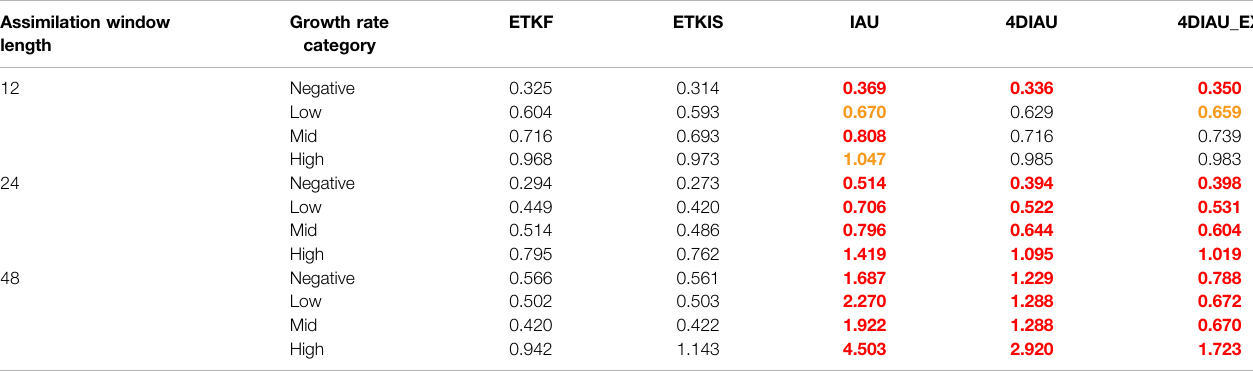
TABLE 2 | RMSE of online cycling experiments. As Table 1 , but for online cycling experiment. Assimilation window